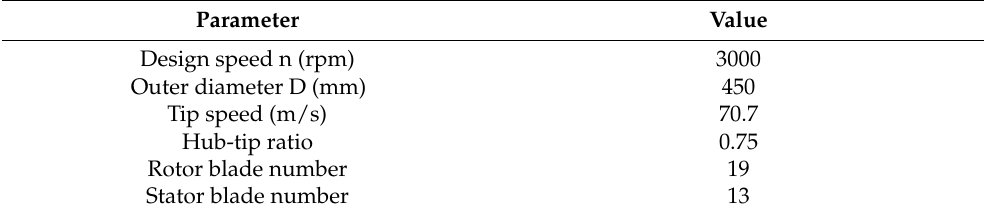
Figure 1. Schematic diagram of the compressor experiment. ( a ) Compressor test rig; ( b ) sensors’ location. Table 1. Main design parameters of